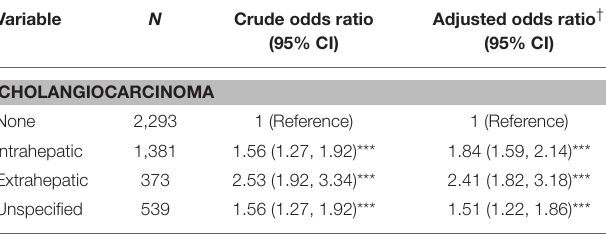
TABLE 4 | Odds ratios and 95% confidence intervalsin various subtypes of cholangiocarcinoma associated with proton pump inhibitor.